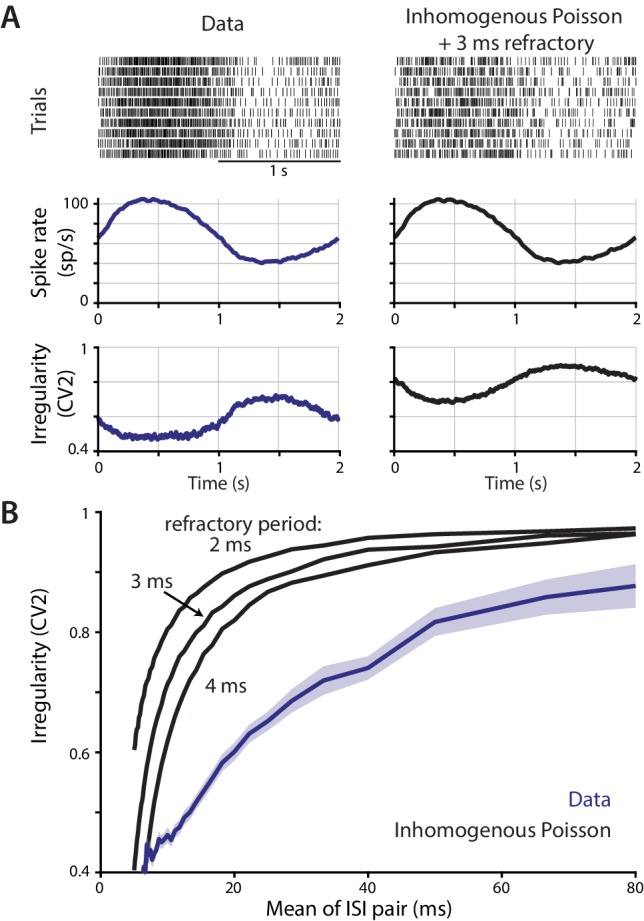
Contribution of a refractory period to the relationship between instantaneous spike rate and irregularity.The possibility that the inverse relationship between spike rate and irregularity observed in vivo could be accounted for by an absolute spike refractory period was assessed using a simple model of spike train statistics. (A) Top, trial-aligned spike raster plots for an example neuron recorded in monkey during smooth pursuit (left column), and for an inhomogeneous Poisson process with a 3 ms absolute refractory period (right column) with rate modulated to match the trial-averaged rate of the example neuron. Bottom, spike rate and spike irregularity (CV2) for all Purkinje cells recorded during smooth pursuit from Figure 1B (left) and all rate-matched Poisson simulations (right). (B) The relationship between the instantaneous irregularity (CV2) and instantaneous spike rate of pairs of ISIs, averaged across cells, for both real and simulated spike trains. For each cell, the CV2 and spike rate were calculated for each pair of ISIs, and the data were then binned and averaged according to the instantaneous rate. The simulated spike trains generated by the refractory Poisson model for each cell were treated identically to the real spike trains. Poisson spike trains were simulated with absolute refractory periods of 2 ms, 3 ms, or 4 ms as indicated. Note that a Poisson process without a refractory period would have an average CV2 equal to one across all ISI durations. The refractory Poisson models exhibit less irregularity at faster spike rates (shorter ISI durations), as also observed in the Purkinje cell data. However, irregularity drops off steeply only at the shortest ISIs in the models, whereas in the data there is a more gradual change in irregularity across the range of ISIs. Thus, a refractory period does not readily account for the relationship between spike rate and irregularity observed in the data, and other factors such as synaptic input are likely to contribute.